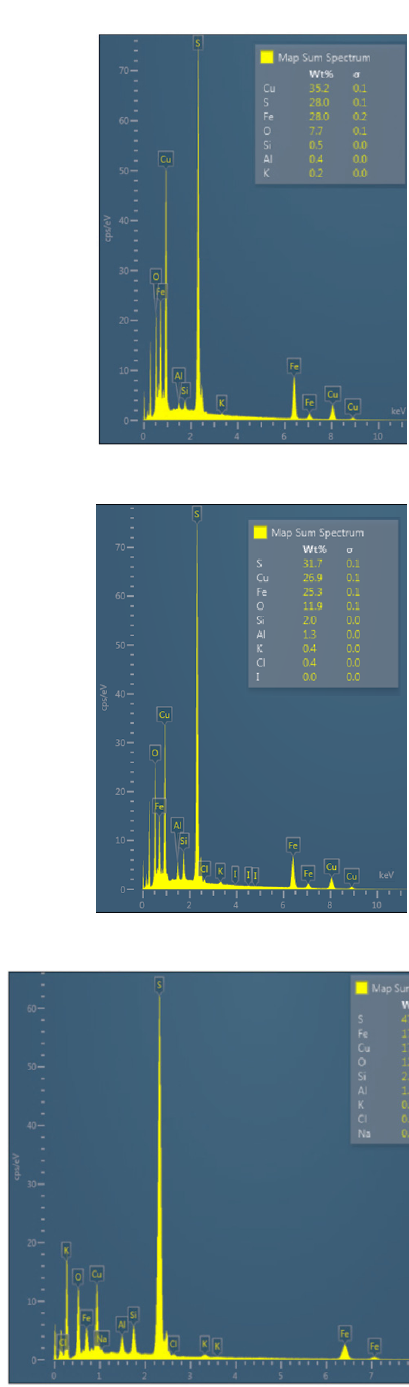
Figure 16. SEM and EDS analysis of chalcopyrite particles with ( a ) H 2 SO 4 = 0.0 M and KI = 100 ppm, ( b ) H 2 SO 4 = 0.5 M and KI = 100 ppm, and ( c ) H 2 SO 4 = 1.0 M and KI = 100 ppm. [Conditions: 45 °C, 50 g of sample with 1000 mL of solution with seawater, 450 rpm].